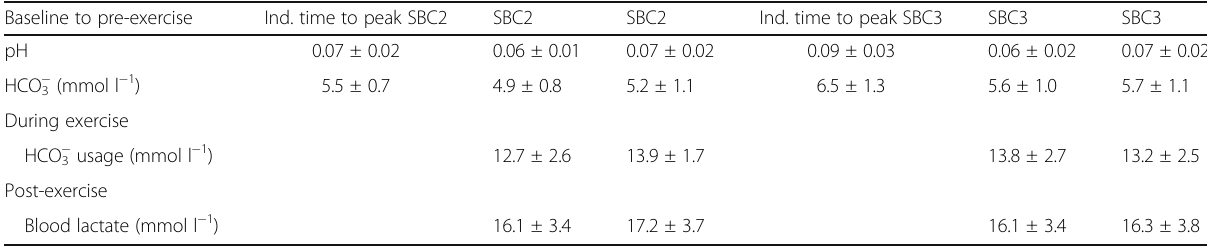
Table 2 Mean (± SD) blood pH, bicarbonate (HCO 3 − ) and lactate responses following sodium bicarbonate (NaHCO 3 ) Baseline to